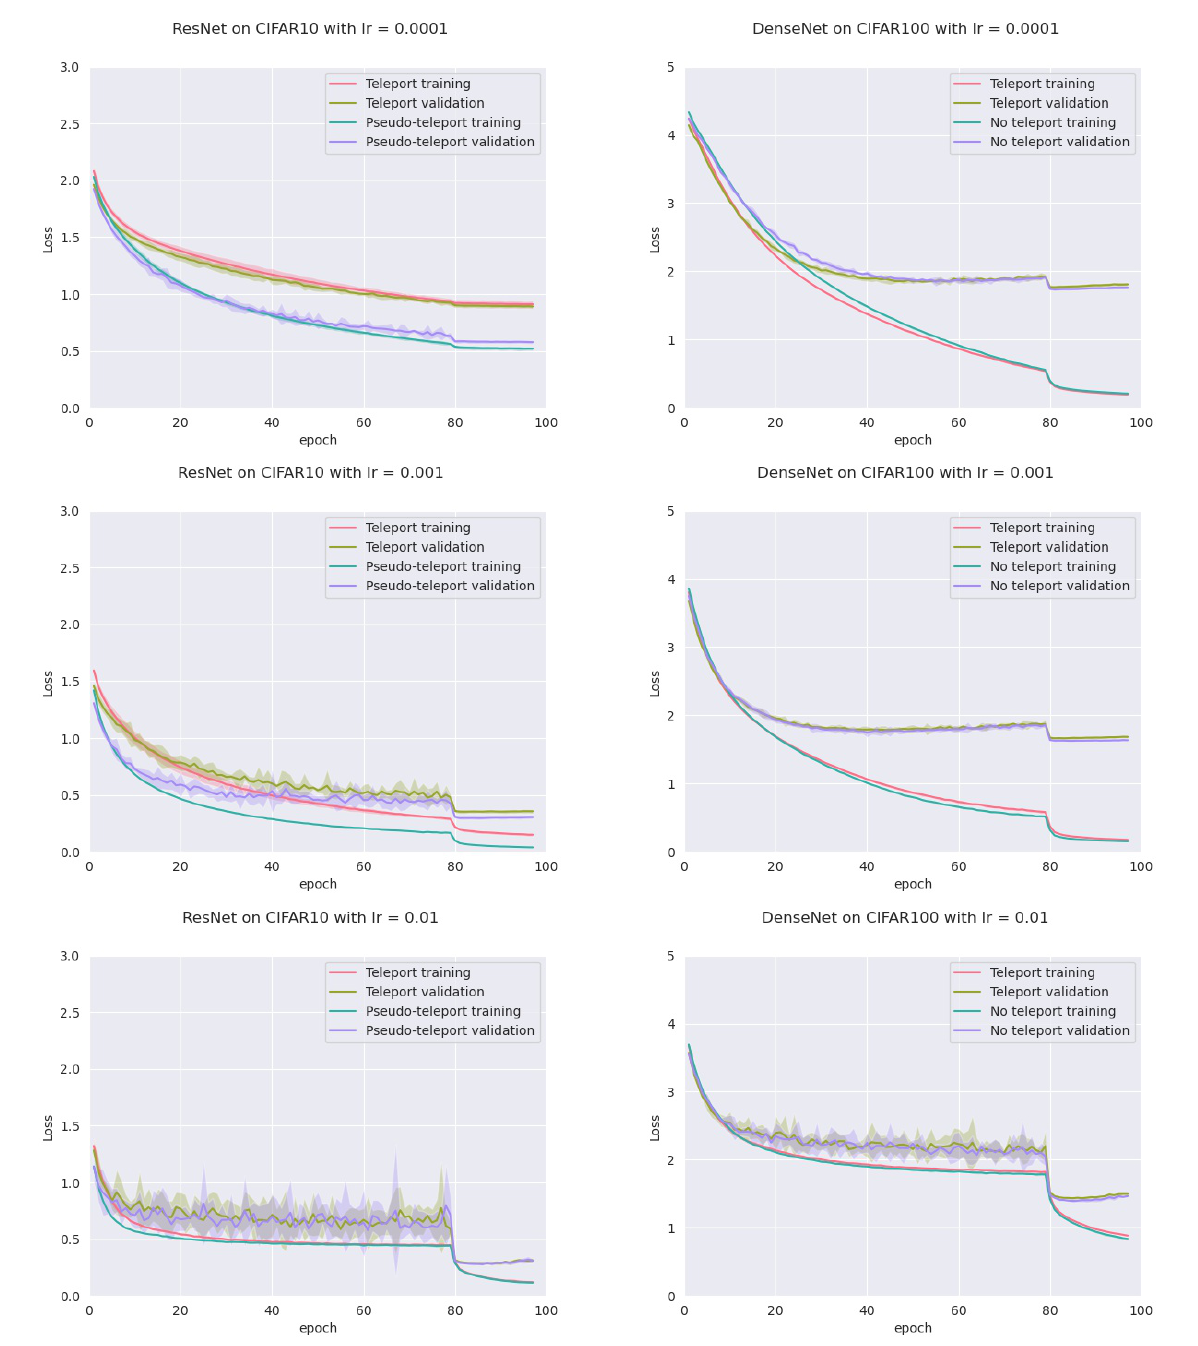
Figure 9. Average loss of ResNet on CIFAR10 ( left ) and DenseNet on CIFAR100 ( right ) both training with SGD over 5 experiments for each, with and without pseudo-teleportation, at the beginning of the training with CoB of 0.9. Learning rate increases from top to bottom rows. We also show a shadow around the average curves at two times the standard deviation over the five